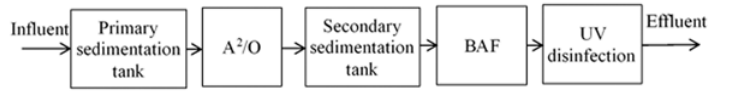
Fig 1. Treatment process for the chosen municipal wastewater treatment